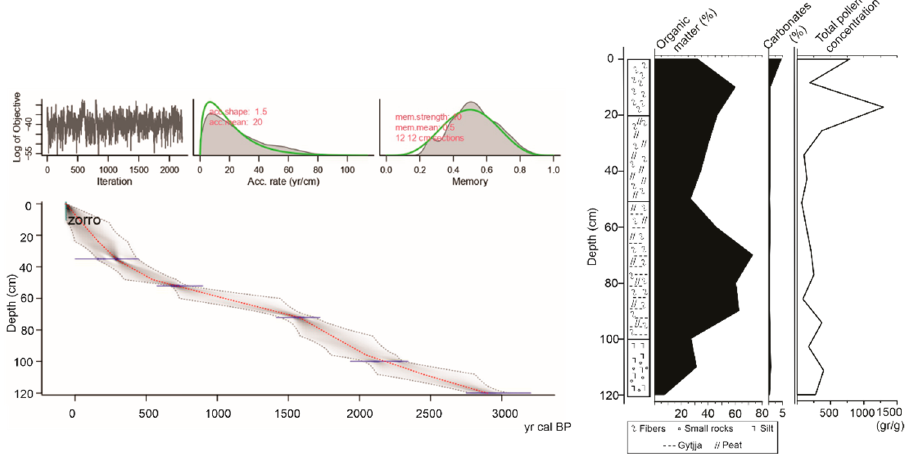
Figure 3. Stratigraphy, loss on ignition, pollen concentration and age model of Zorro Bayo wet meadow. wet